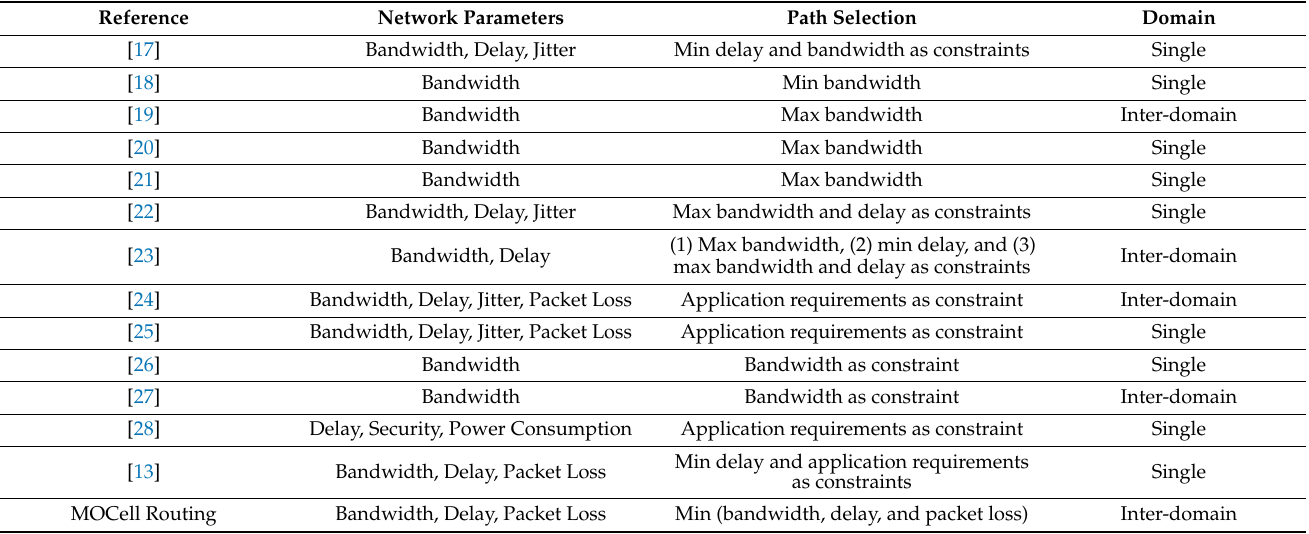
Table 1. Comparison of QoS routing